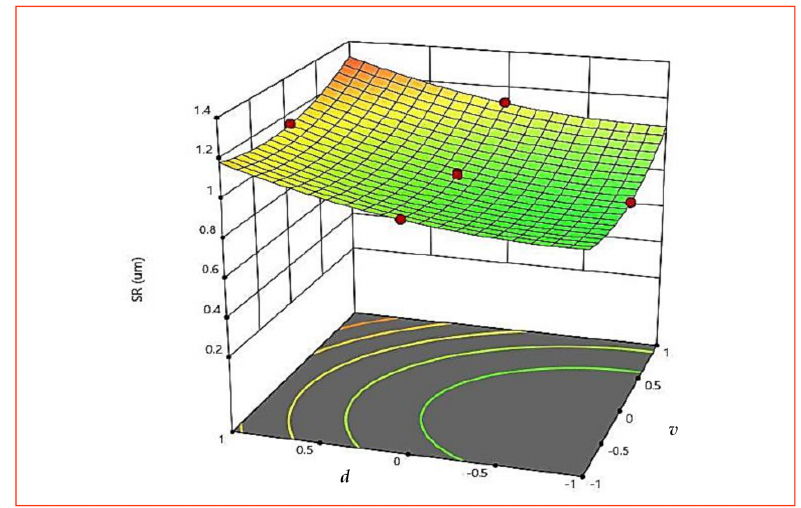
Figure 11. The 3D surface plot for SR ( v × d ).